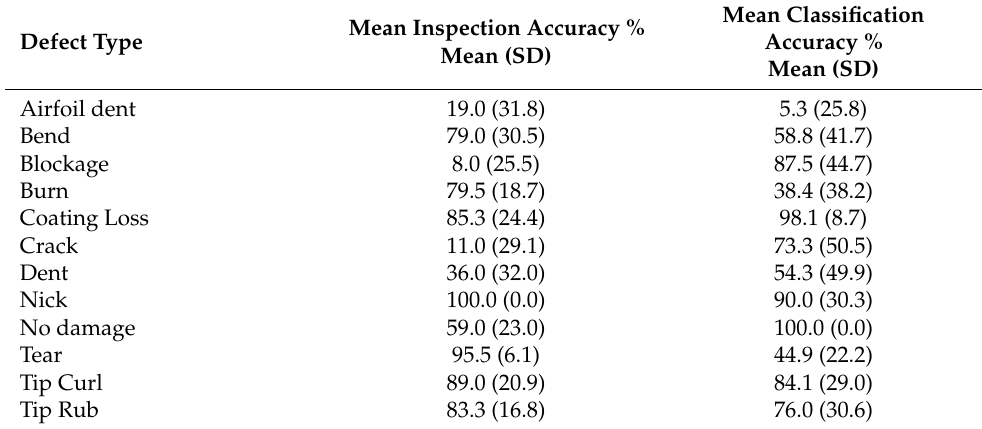
Table 3. Inspection accuracy and classification accuracy by defect type (in